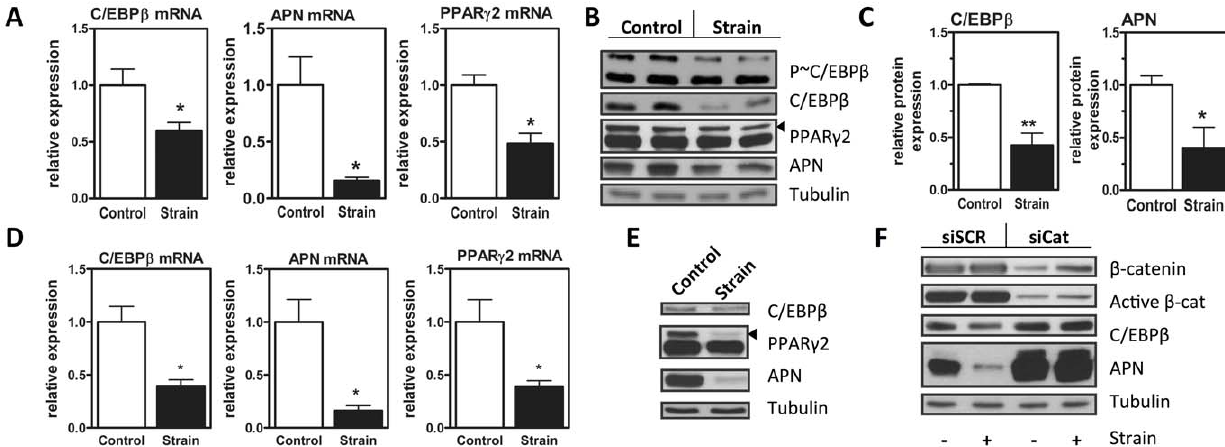
Figure 1. C/EBP b is a mechanical target in MSC. A, mRNA of C3H10T1/2 cells in adipogenic media subjected to strain, analyzed via real time PCR for C/EBP b , adiponectin (APN), and PPAR c 2, n=3, *p , 0.05. B, Immunoblot of day 3 C3H10T1/2 cells in adipogenic media subjected to strain. C, Densitometry from (B) n=4, * p , 0.05, ** p , 0.01. D, mRNA of mdMSC in adipogenic media treated with strain, analyzed via real time PCR for C/EBP b , adiponectin (APN), and PPAR c 2, n=3,*p , 0.05. E, Representative immunoblot of day 2 mdMSC cells in adipogenic media subjected to strain, n=3. F, C3H10T1/2 cells transiently transfected with siRNA to b -catenin. 24 hr later, induction of adipogenesis was initiated with adipogenic media. Strain was applied and immunoblot performed for b -catenin, active b -catenin, as well as C/EBP b , and adiponectin (APN).